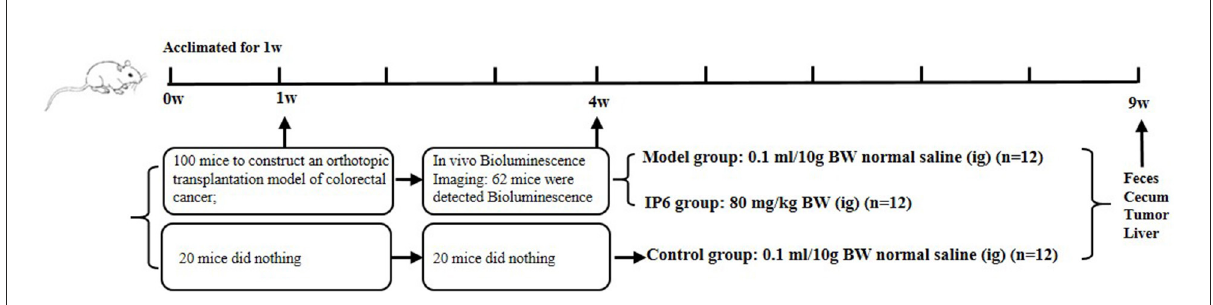
FIGURE1 Study design showing model construction, in vivo Bioluminescence imaging, grouping, and